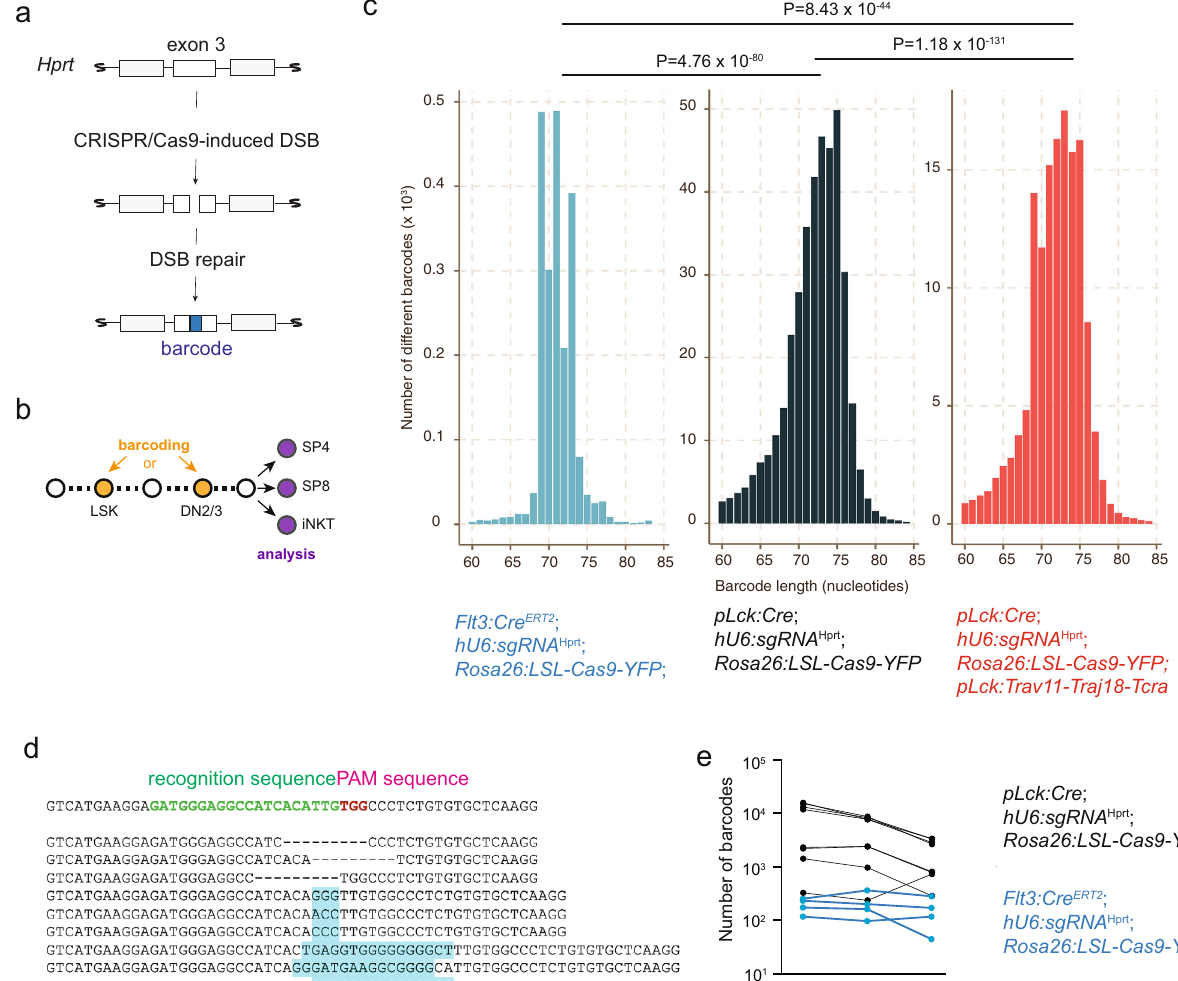
Fig. 1 Characterization of the barcoding system. a Schematic illustrating the successive steps in barcode generation. b Schematic indicating the two stages of barcoding at the LSK bone marrow progenitor, and the DN2/3 immature thymocyte stages; the common analysis time point at the mature thymocyte stage is also indicated. c Size distributions of barcode sequences in mice of the indicated genotypes. The values for mean±standard deviation are, from left to right, 71.037 ± 2.337 nucleotides; 72.038 ± 3.782 nucleotides; 71.762 ± 3.602 nucleotides, respectively. P values for two-way comparisons are indicated (t-test). d Examples of barcode sequences with deletions (indicated by dashes) and insertions (highlighted by blue shading). The fi rst nucleotide in the wild-type sequence corresponds to nucleotide 303, the last nucleotide corresponds to nucleotide 354 in Genbank accession number NM_013556.2. e Number of barcodes recovered from individual thymocyte populations in mice of the indicated